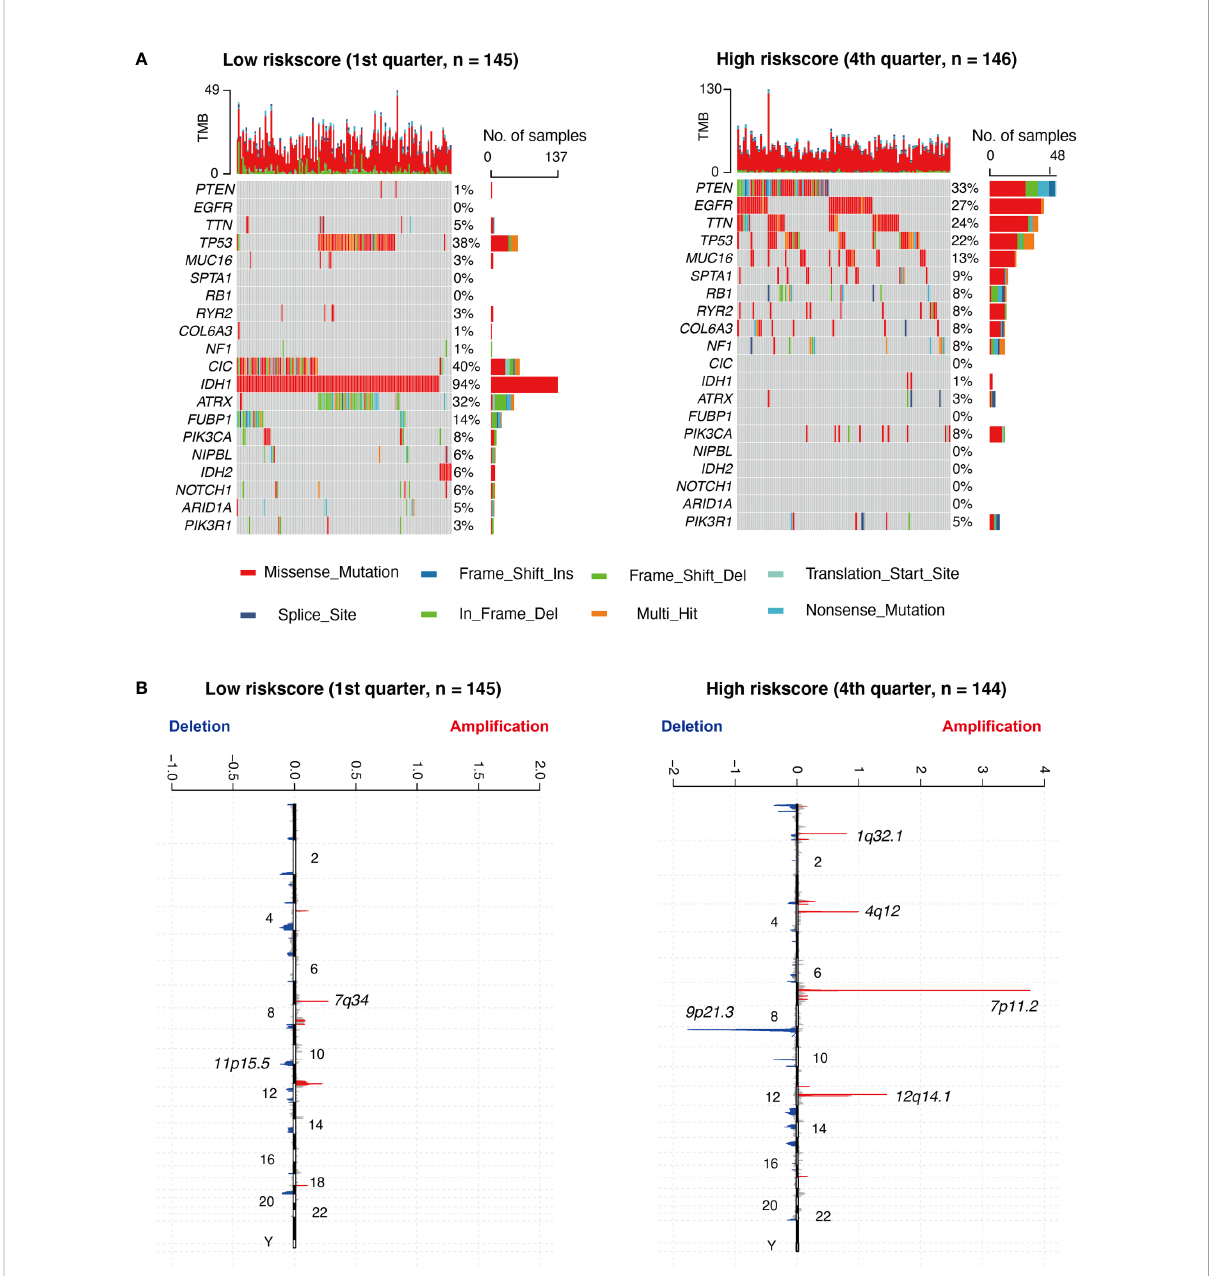
FIGURE 5 Different genomic pro fi les are associated with risk score. (A) Differential somatic mutations were detected by comparing glioma with low- and high- risk score groups. (B) A different CNAs pro fi le could be observed between low- and high- risk score groups. Chromosomal locations of peaks of signi fi cantly focal ampli fi cation (red) and deletions (blue) were